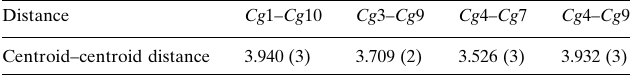
Weak Cg – Cg intermolecular interactions of (I) (A˚ ).